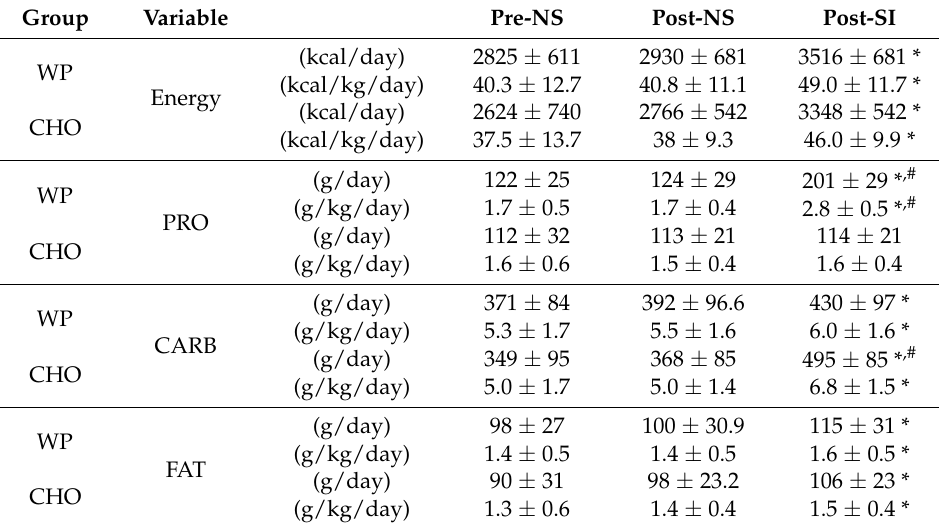
Table 1. Summary of dietary intake during